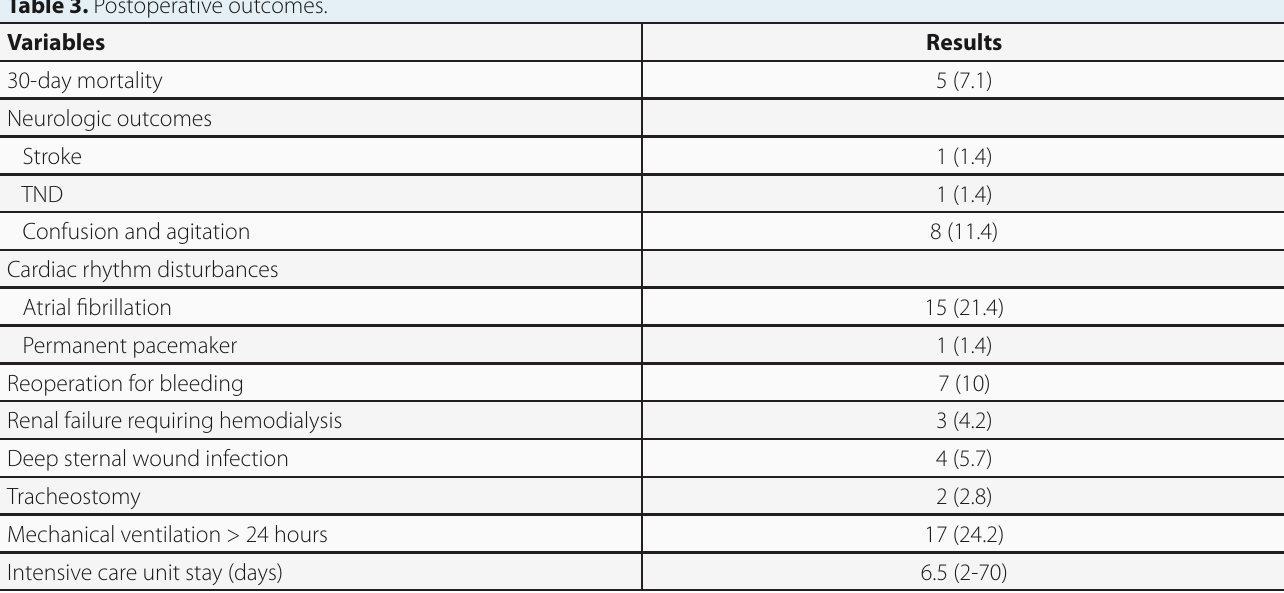
Table 3. Postoperative